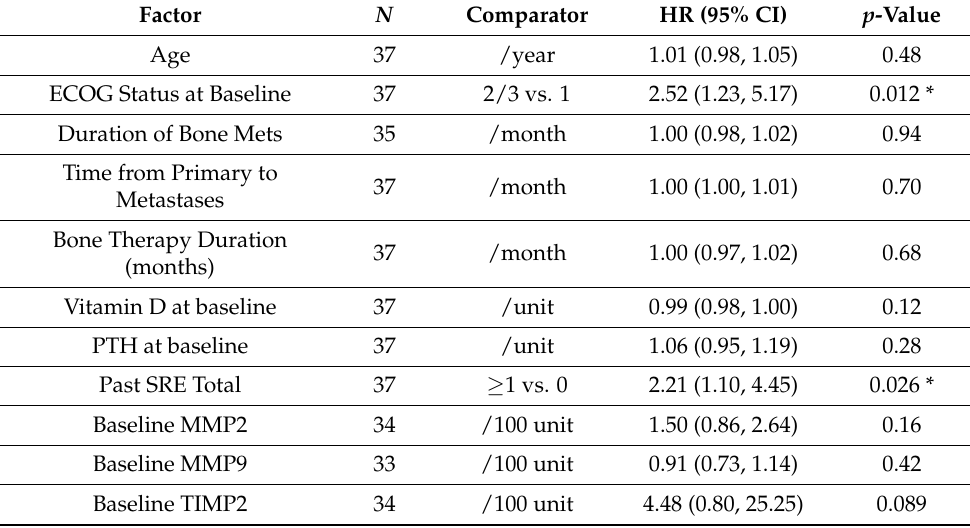
Table 5. Cox regression for prognostic factors of SRE-free